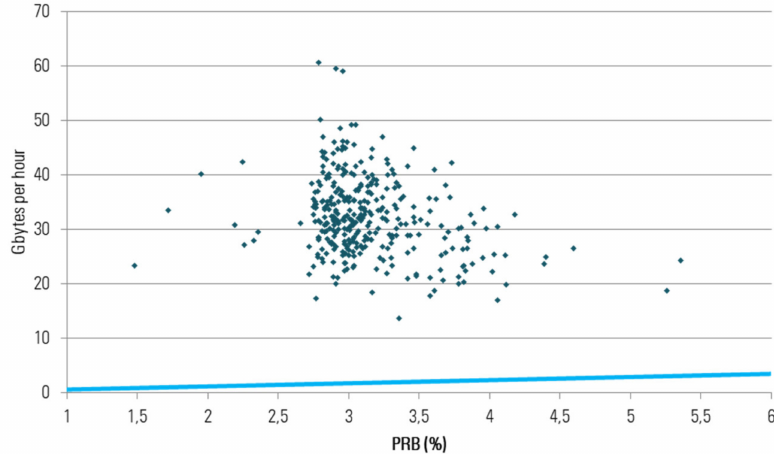
Figure 10. Cell throughput vs. PRBs used (theoretical and empirical) for 60